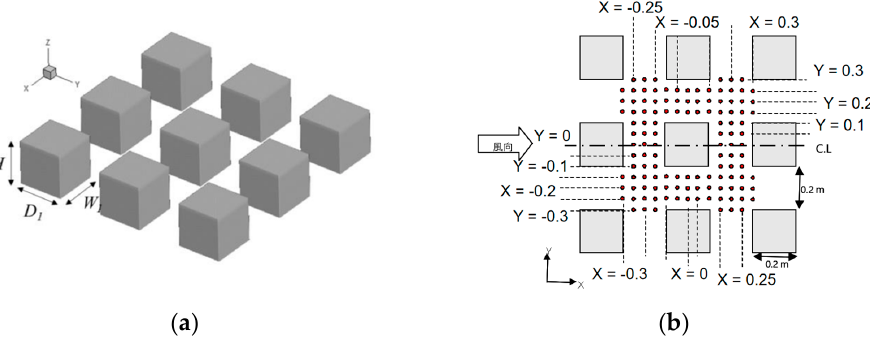
Figure 1. Wind tunnel model and schematic diagram of measuring points.( a ) A wind tunnel experimental physical model. ( b ) Measuring point azimuth diagram.